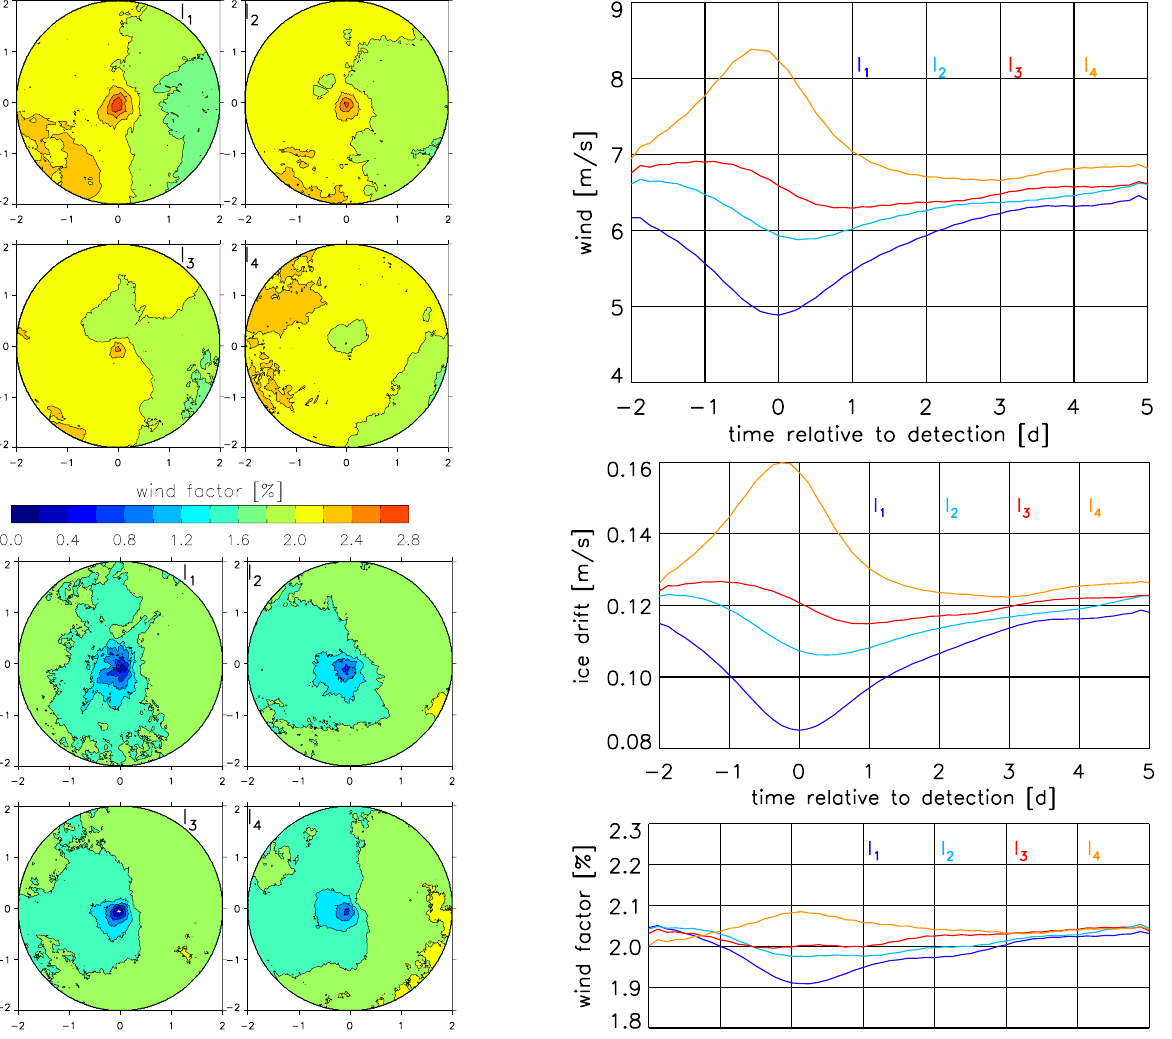
in ice concentration is stronger than in the other three classes.